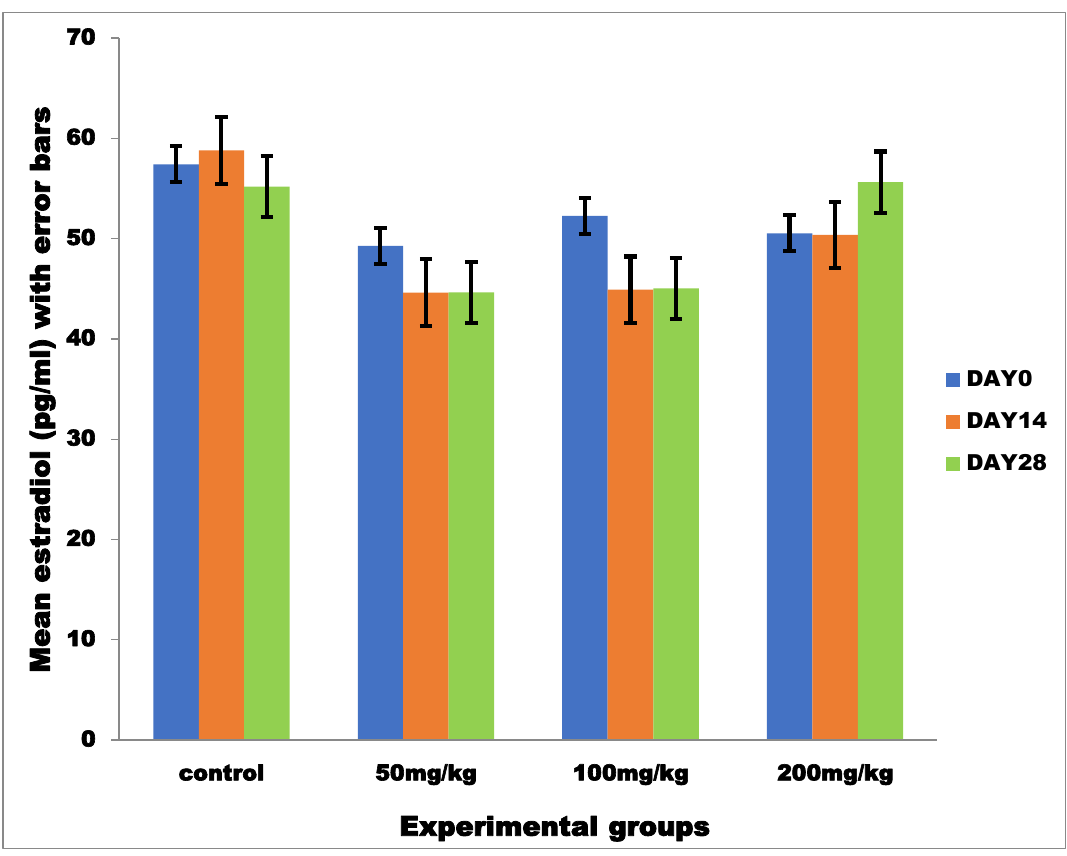
Figure 4. Mean serum estradiol levels in female albino rats exposed to graded doses of MSEAI at different time points.